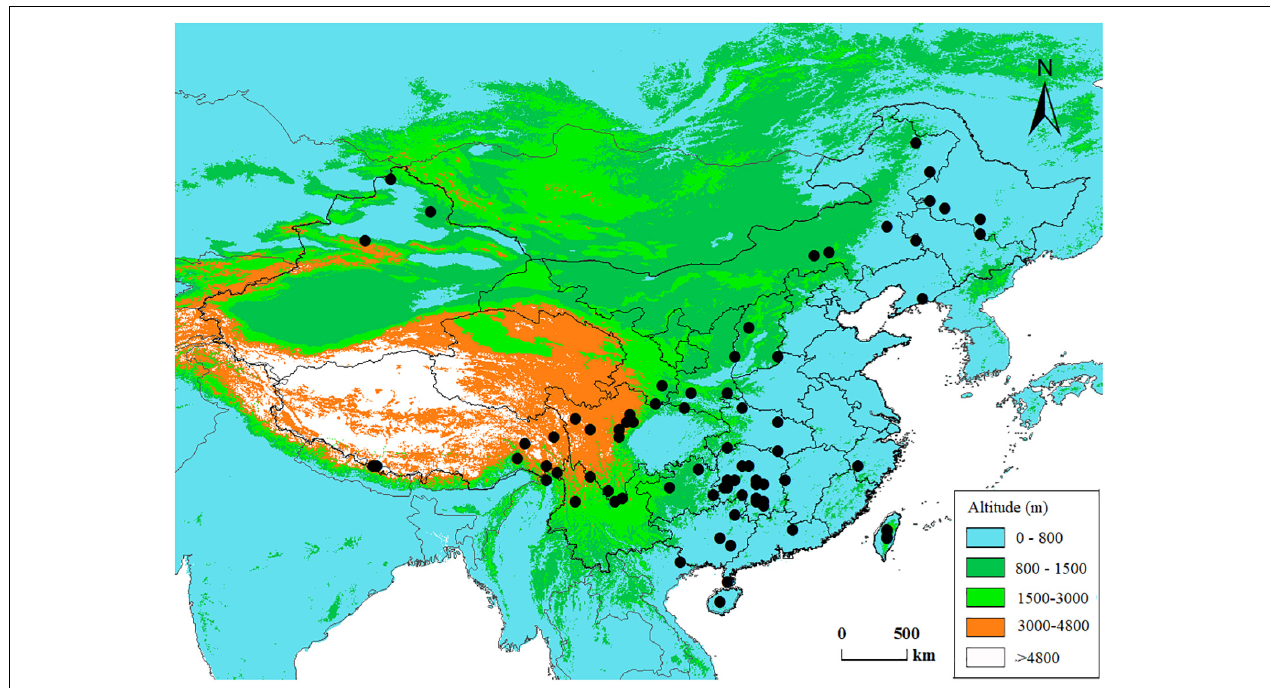
FIGURE 1 | Spatial distribution of the data in this study. Each dot represents a species’ central distribution location on land of China, using the mid-latitude and mid-longitude values of the species’ range in the country as